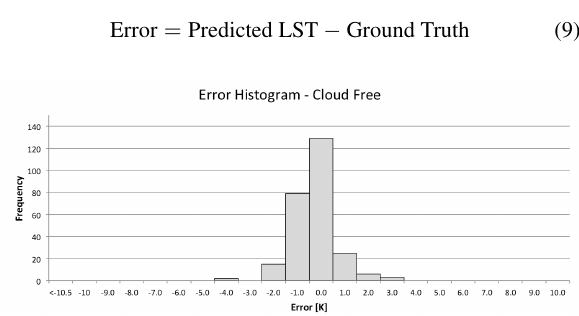
Figure 2: Error histogram for cloud free Landsat 5 validation